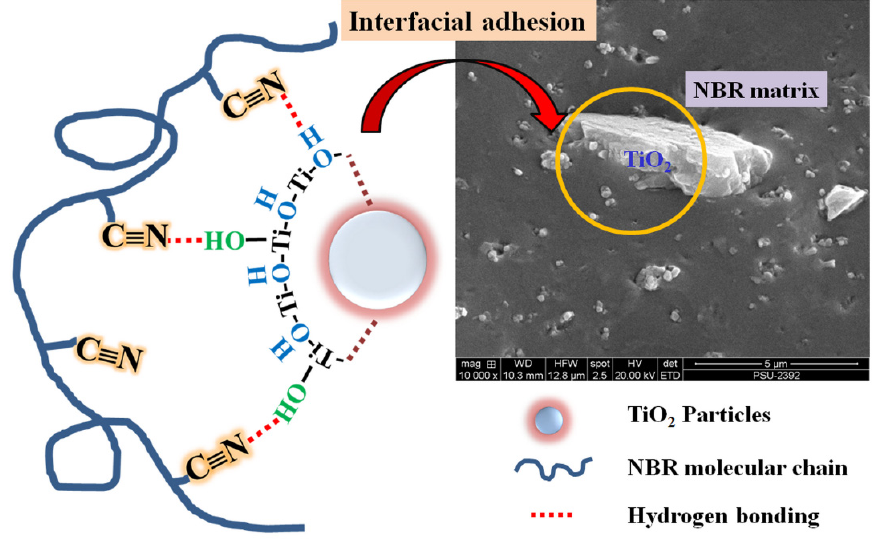
TiO 2 -filled NBR composites is shown in Scheme 1.